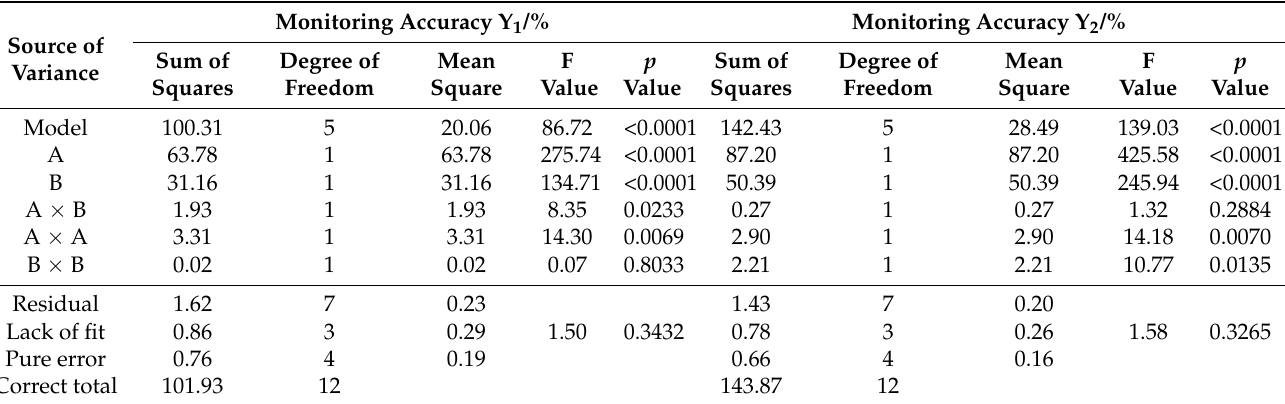
Table 6. Variance analysis of regression